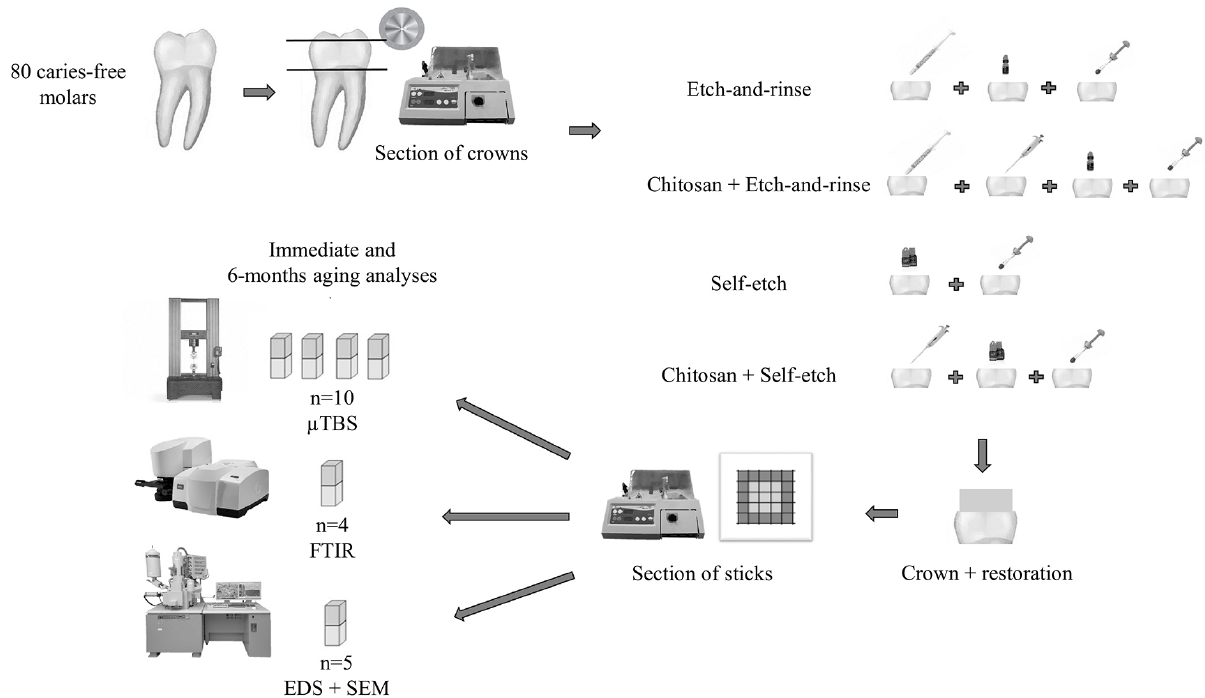
Figure 1- Schematic illustration of the experimental